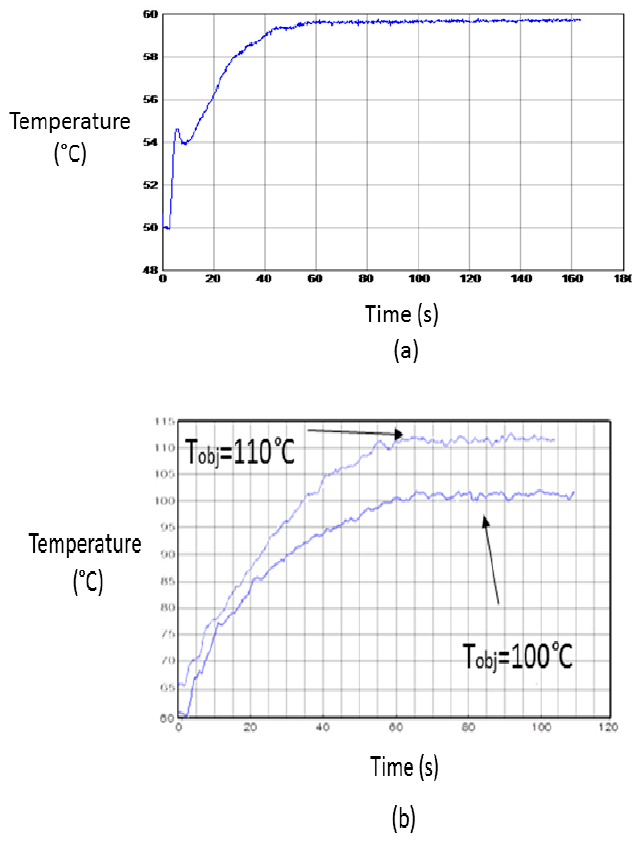
Figure 8. Temperature profiles of developed experiments. ( a ) Low-temperature process; and ( b ) high-temperature process.